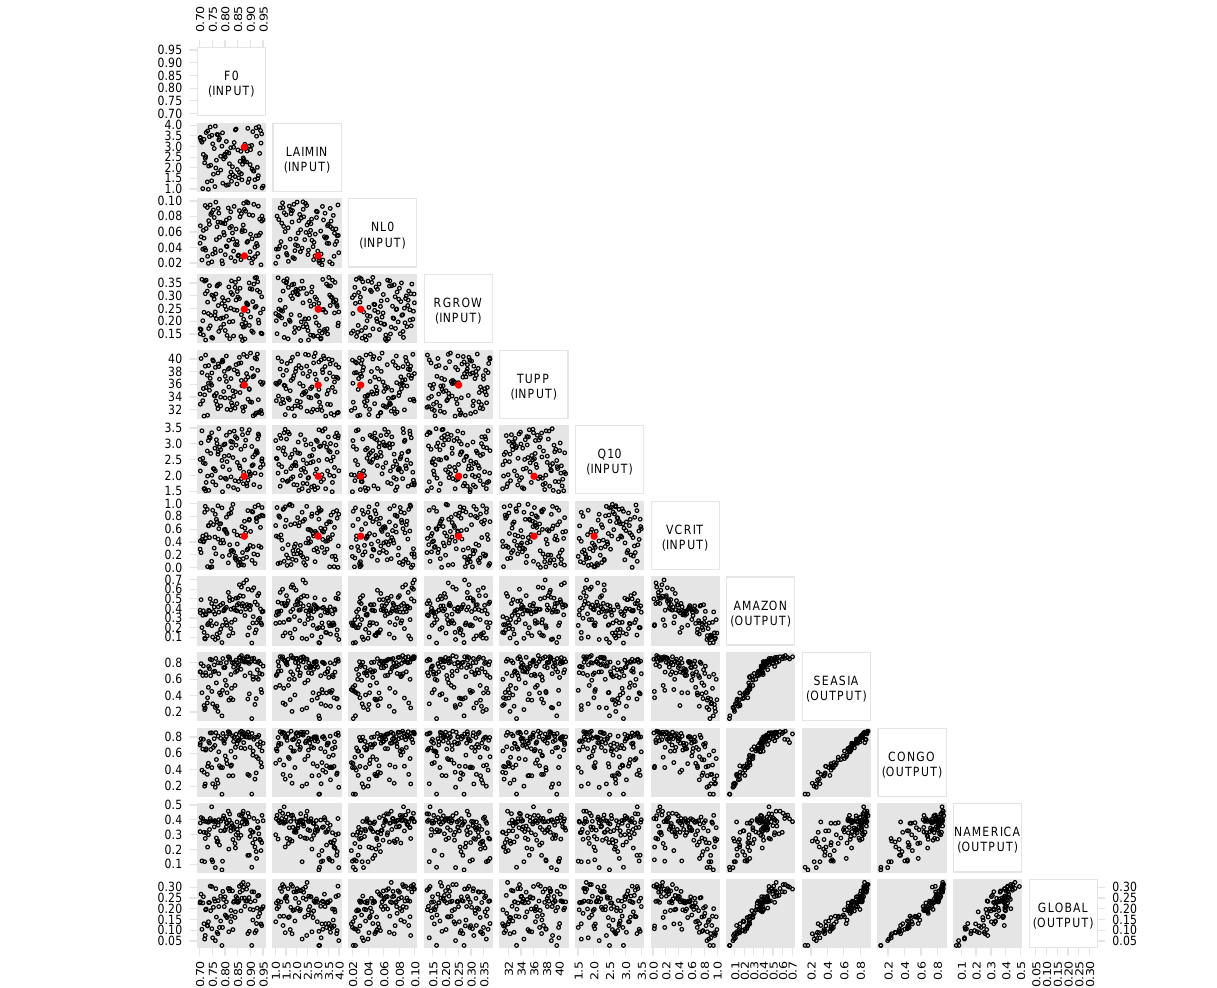
Figure 2. FAMOUS input parameters and forest fraction parameters, plotted against each other. Default inputs (not run) are marked in